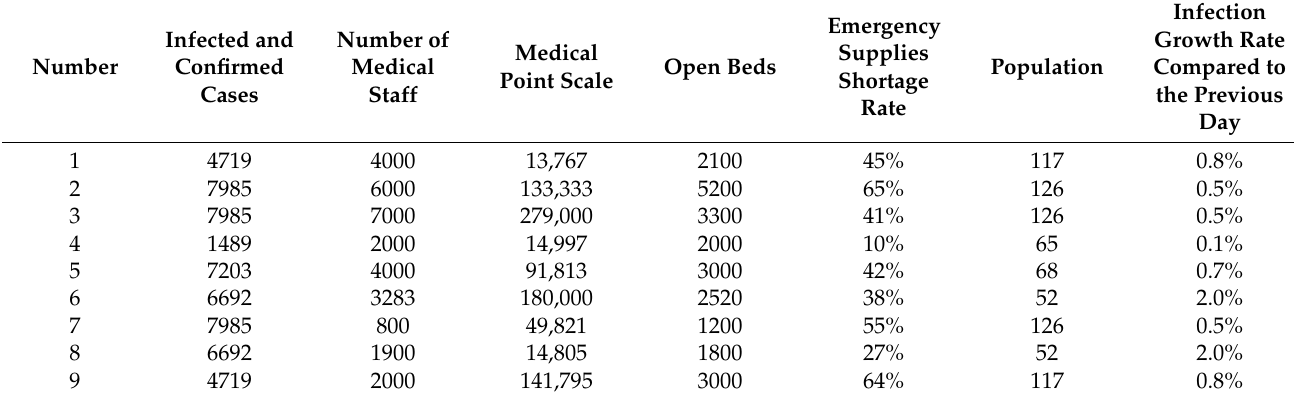
Table 1. Medical-related information of each